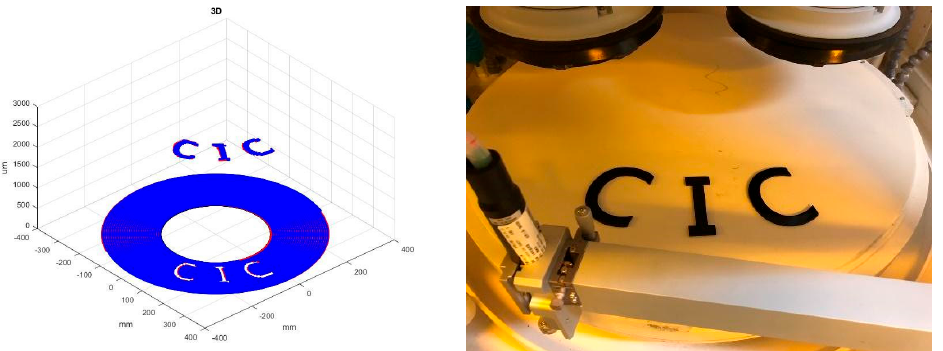
Figure 7. Re − allocating the measurement data into the surface.